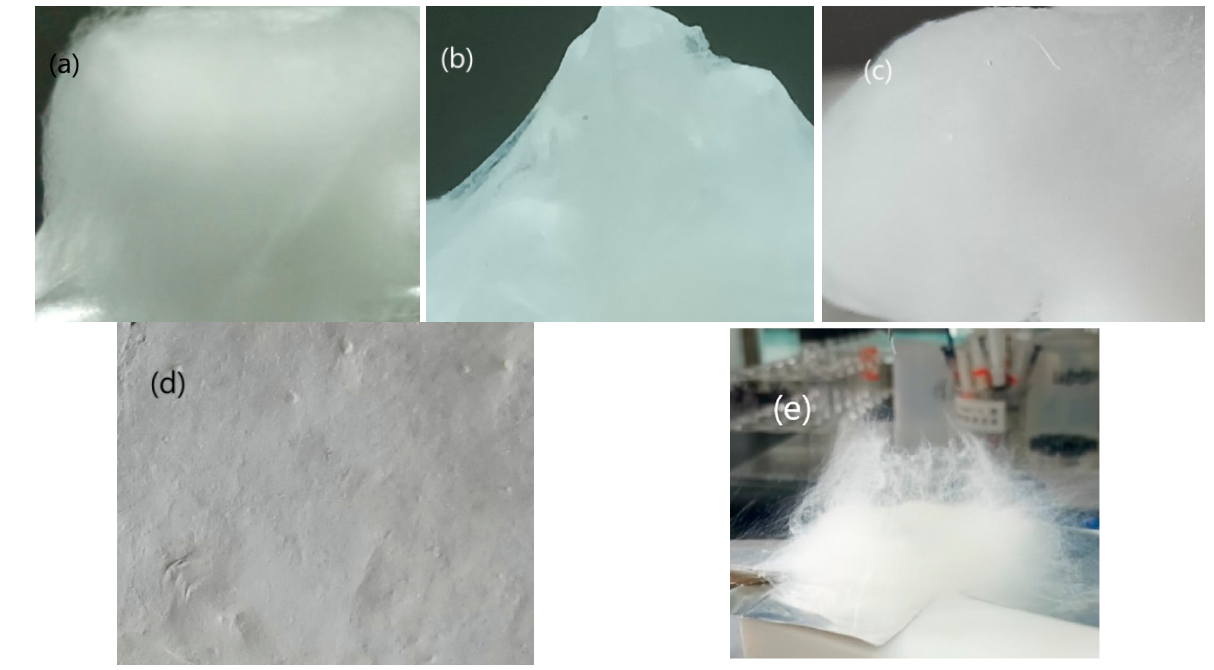
Figure 4. The optical photographs of electrospun NC-based composite fibers (( a )—sample 1, ( b )—sample 2, ( c )—sample 3, ( d )—sample 4, ( e )—the vertical growth of the fluffy NC fiber).